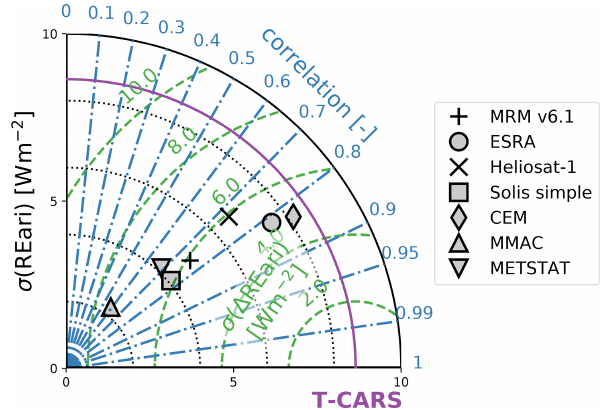
Figure 9. The REari simulated with different CSMs as the average over all DWD observation stations is compared to the collocated T– CARS simulation. The annual variability is indicated by the SD ( σ ) of the individual dataset. The performance of the individual CSM is displayed by the SD of REari difference and correlation versus T–CARS.